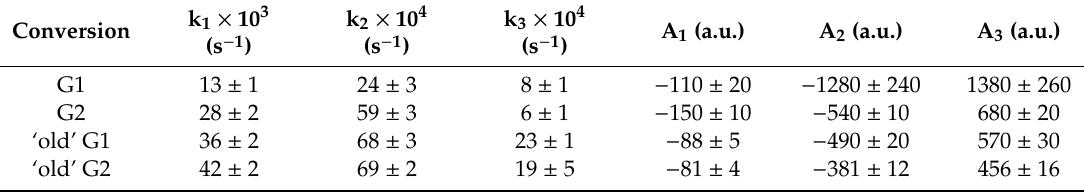
Table 1. Kinetic parameters in the reaction of green-to-red photoconversion (PC) of SAASoti ( ± S.E.).